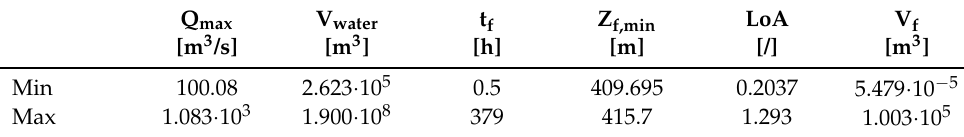
Table 5. Range of the Input and Target used for normalization.